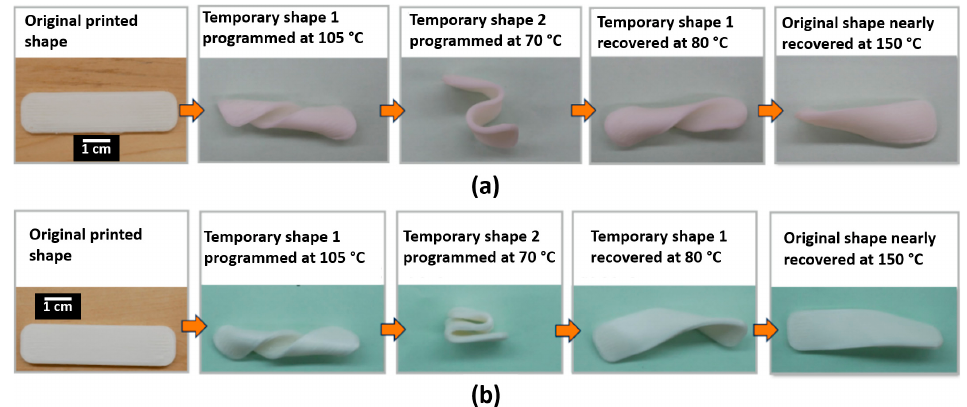
Figure 15. Manual shape memory experiments with the goal of achieving multiple programmed temporary shapes for ( a ) PLA:SEBS 50:50 and ( b ) PLA:TPU 50:50. The specimens were FFF-manu-